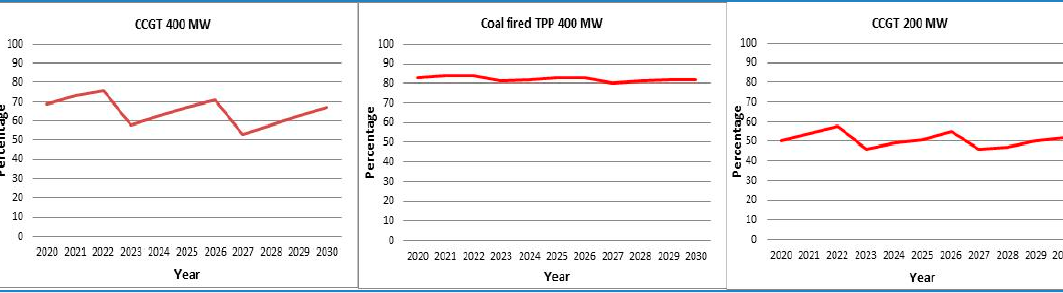
Figure 12. LOLP and OC in a scenario with LOLP = 0.01% and VOLL $2 USD/kWh.